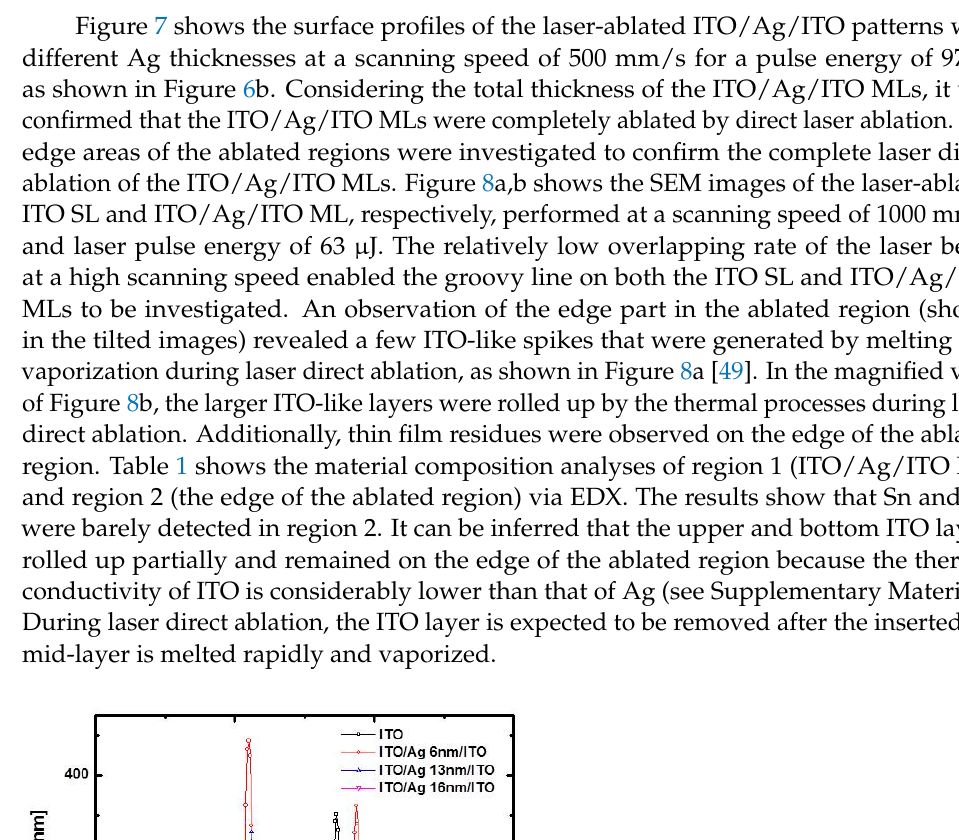
Figure 6. Lines widths of laser-ablated ITO/Ag/ITO MLs as a function of Ag thickness with ( a ) different laser pulse energies (scanning speed, 500 mm/s) and ( b ) different scanning speed (laser pulse energy, 97 μ J).